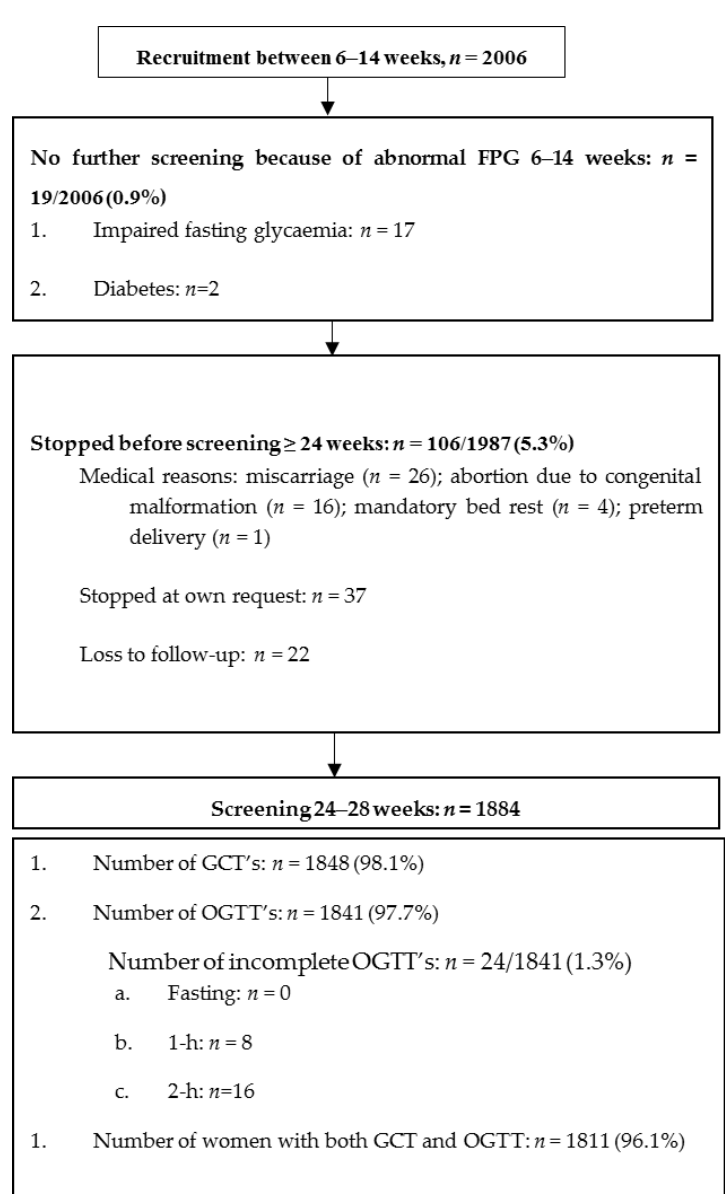
Figure 1. Flow of participants. FPG: fasting plasma glucose; GCT: 50 g glucose challenge test; OGTT: 75 g 2 -h oral glucose tolerance test.